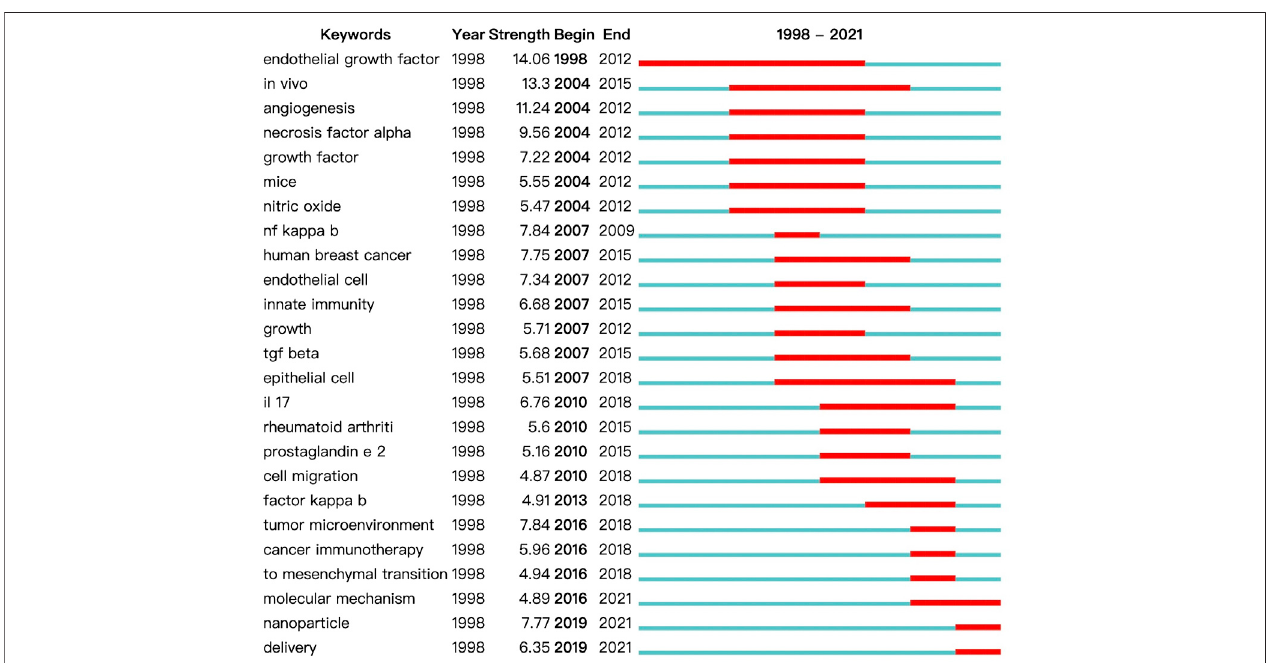
FIGURE 8 | Top 25 keywords with the strongest citation bursts on in fl ammatory tumor microenvironment.